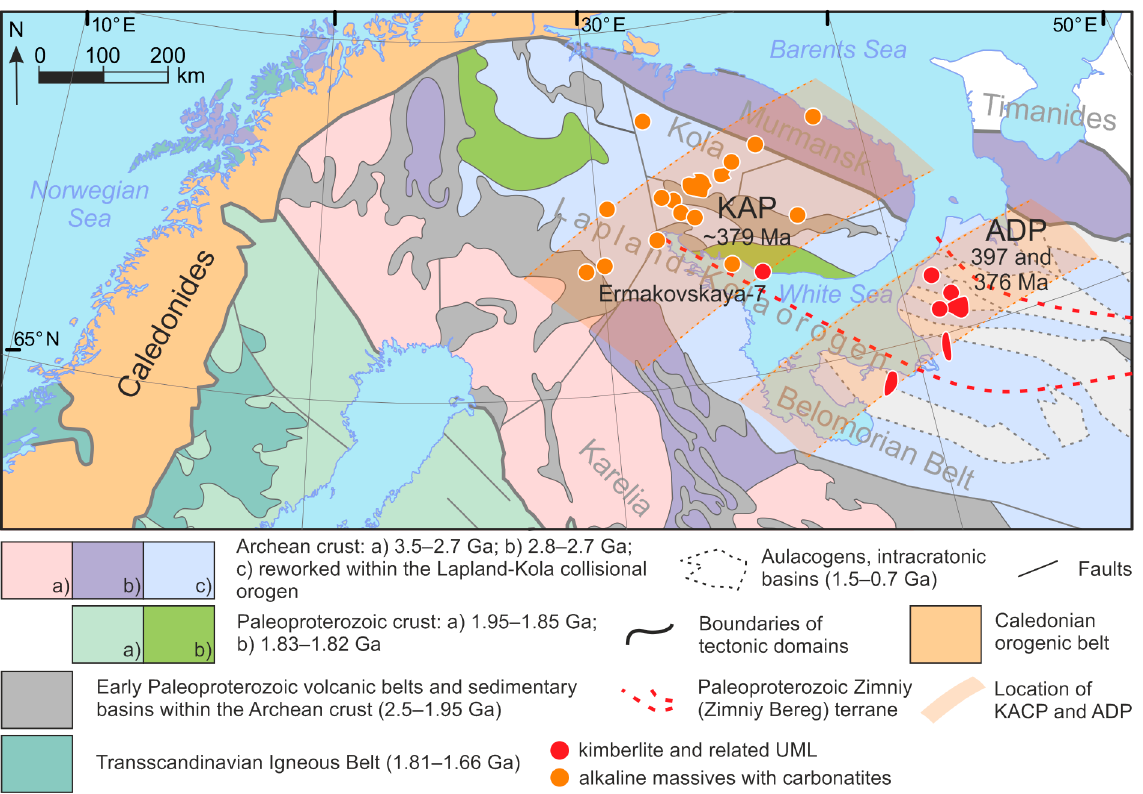
Figure 15. The Precambrian crust of Fennoscandia comprises an Archean part in the northeast and a Proterozoic part in the southwest after [47] with the position of alkaline-ultramafic magmatism of ADP and KACP as well as the position of the Caledonian orogenic belt.